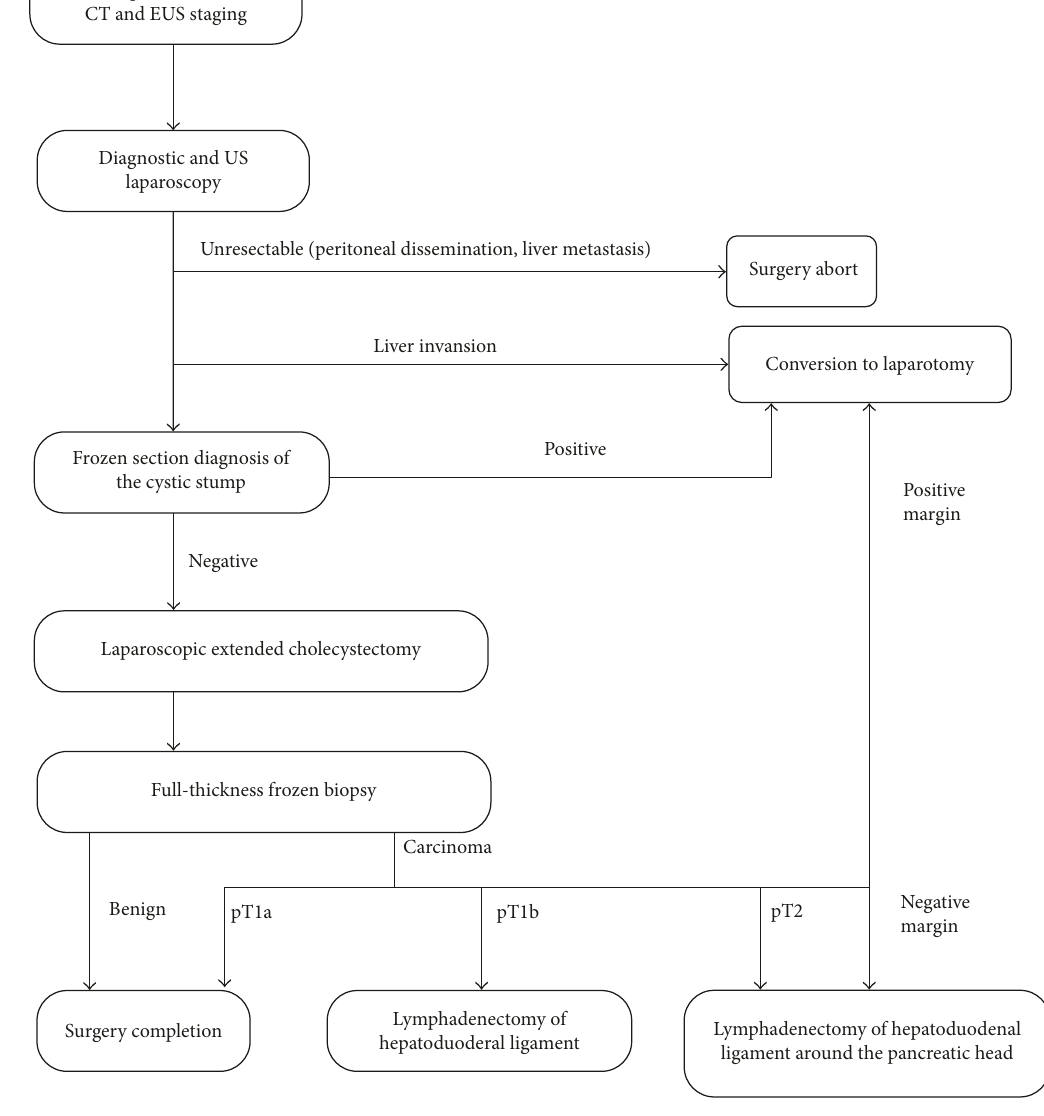
Figure 2: Surgical approach for primary